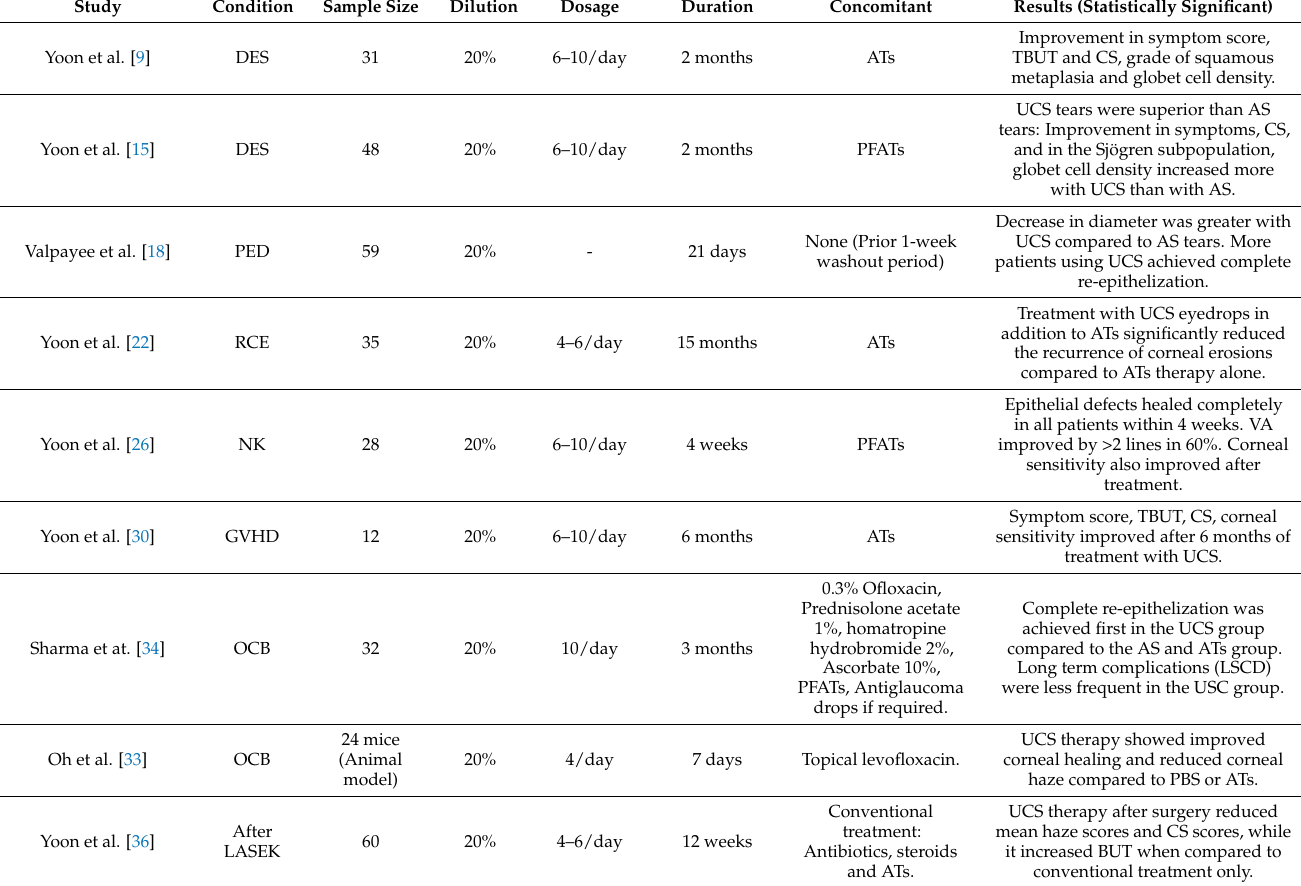
Table 2. Umbilical cord serum tears applications in